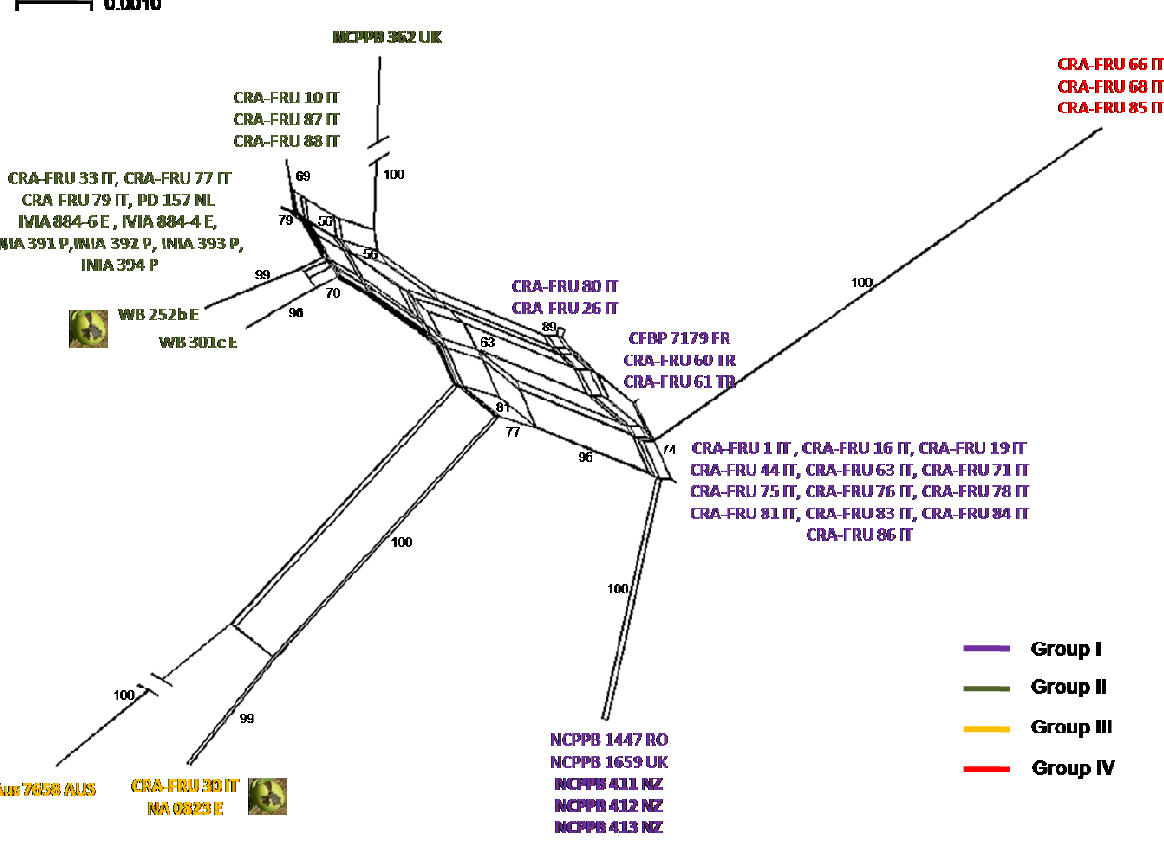
Figure 5. NeighborNet analysis of the concatenated set of four housekeeping genes, acnB , gapA , gyrB and rpoD of X. a. pv. juglandis strains. Bootstrap confidence values are shown along each branch. The X. a . pv. juglandis strains isolated from apical necrosis of walnut fruits are pointed out.